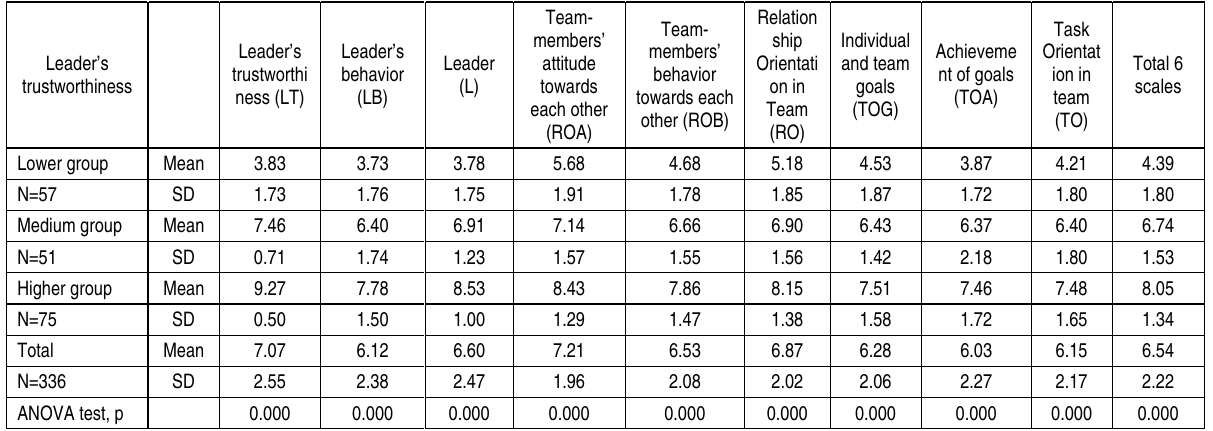
Table 7. Comparison of companies according to lower, medium and higher group of LIC characteristics in 2015